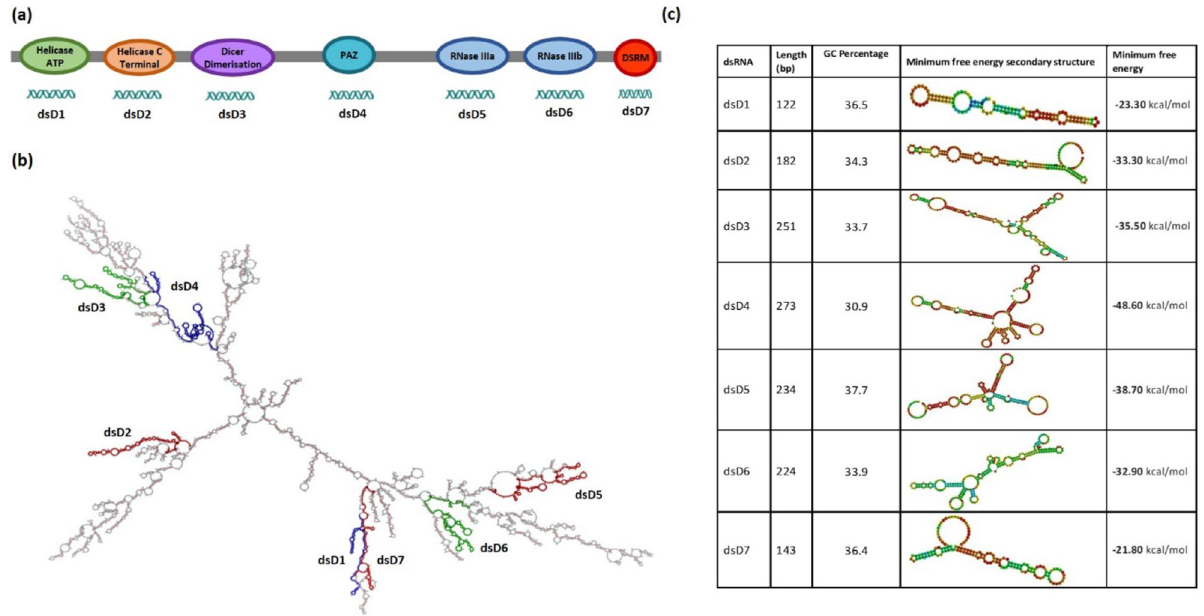
Figure 4. Secondary structures and features of Midcr-1.1 mRNA and the dsRNA triggers. (a) Representation of the six protein domains and motif and the parts used for dsRNA (dsD1 to dsD7) synthesis. (b) Secondary structures of Midcr-1.1 mRNA and the location of the dsRNA triggers. (c) Physical and thermodynamic features of the seven dsRNA triggers used to silence the